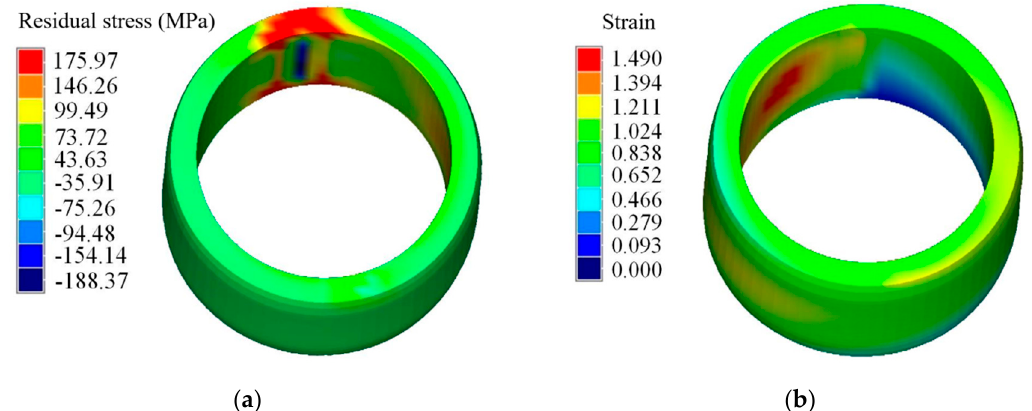
Figure 7. Simulation results of ring ‐ rolling process: ( a ) Residual maximum principal stress result; ( b ) Equivalent plastic strain.